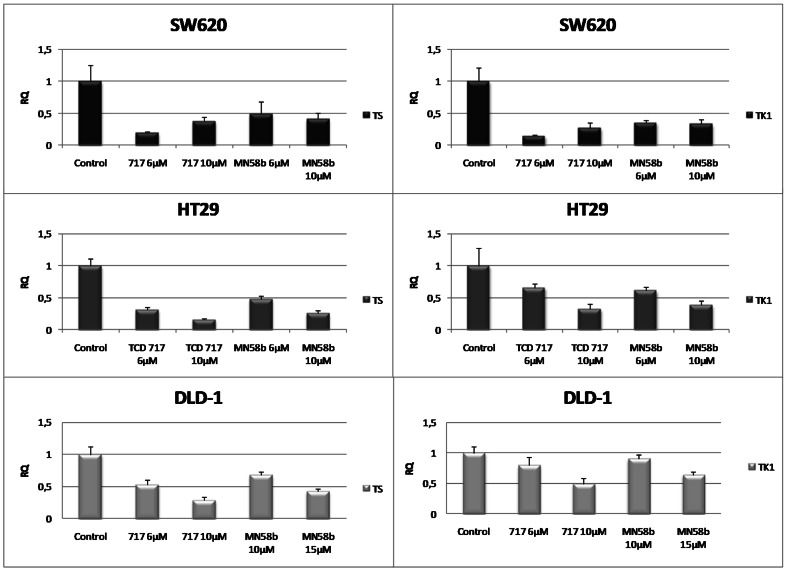
Levels of TS and TK1 in SW620, HT29 and DLD-1 cell lines determined by RT-qPCR.2,5×105 DLD-1, HT29 and SW620 cell lines were seeded in 6 well plates and incubated under optimal conditions for 24 h. Next, cells were exposed to different concentrations of ChoKα inhibitors for 24 h. Levels of TS and TK1 were analyzed by RT-qPCR as described under Materials and Methods. 18S was used as the endogenous control for normalisation.